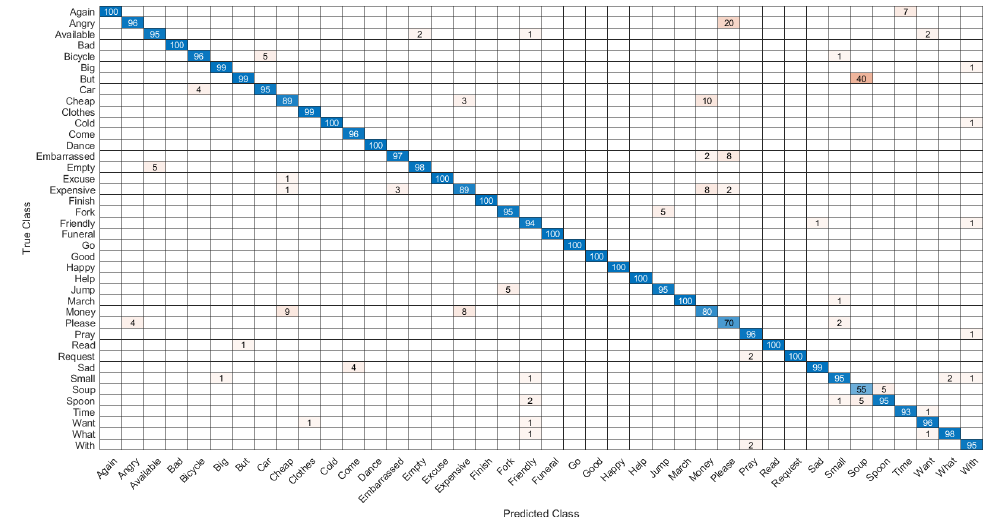
Figure 11. Confusion matrix of the recognition performance of double-hand dynamic ASL words with SGD